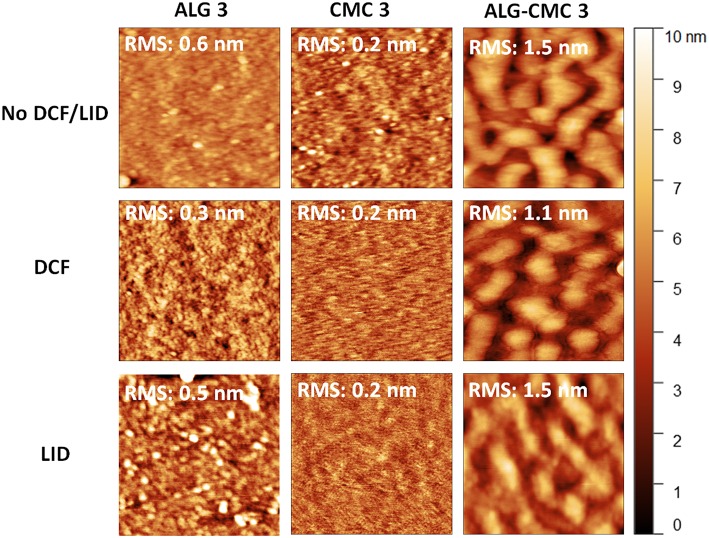
AFM height images (size: 1 × 1 μm2) of polysaccharide nanofilms, without drugs (top), with DCF (middle), and with LID (bottom).